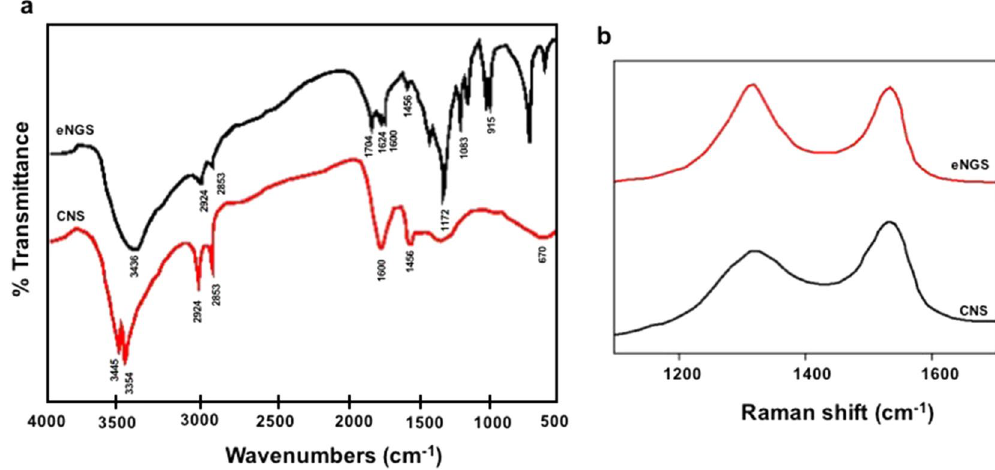
Figure 3. ( a ) FTIR of CNS and eNGS ( b ) Raman spectra (514.5 nm) of CNS and